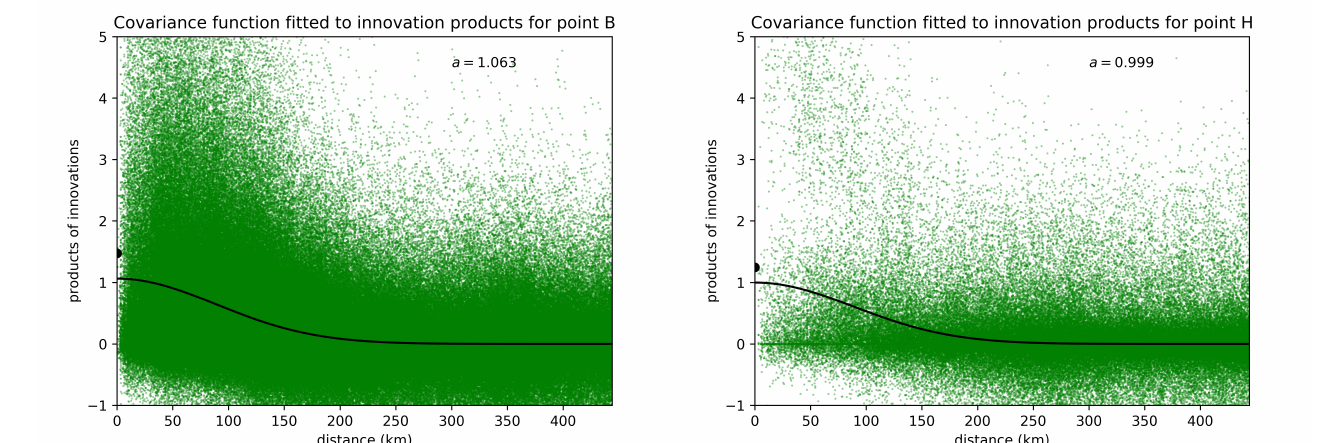
Figure 3. Gaussian function Ψ ( r ) = a e − ( r − r 0 ) 2 / 2 ( 88.8 ) 2 fitted to all pairs of innovation products around points B and H for one particular realisation and 100% of the data. The green dots are products of innovations plotted against the distance between them and the black line is the Gaussian fitted to all points using the PROM method. Each plot has a label with the fitting coefficient a , the theoretical value for this coefficient is 1. The black dots represent the variances at r 0 . The vertical axis limits have been chosen to make the figure more clear, about 3% of the green points lie outside of this range and they are not shown.